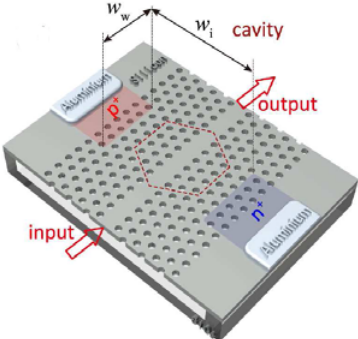
Figure 19. Schematic view of the device proposed by Tanabe et al. [77]. Reprinted with permission from T. Tanabe, et al. Copyright 2010, American Institute of